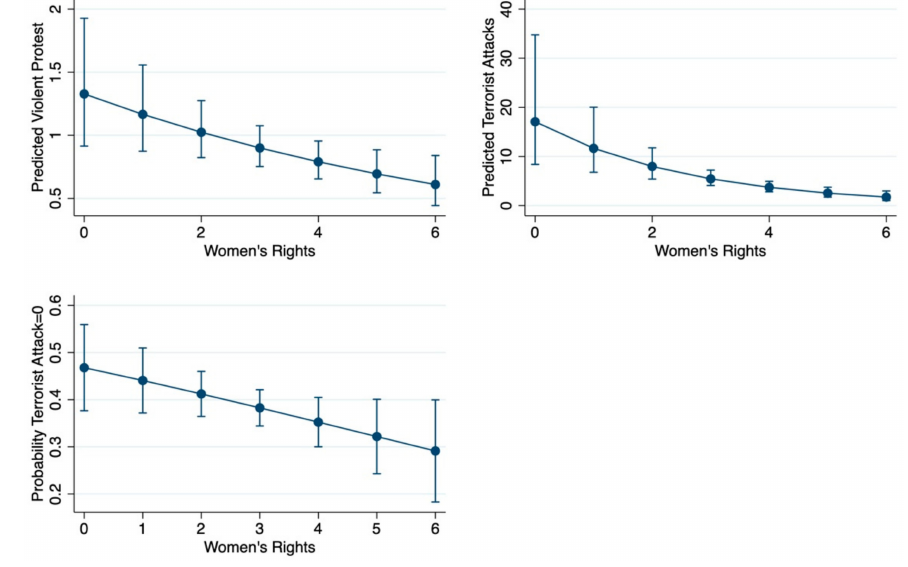
Figure 6. Women’s rights and